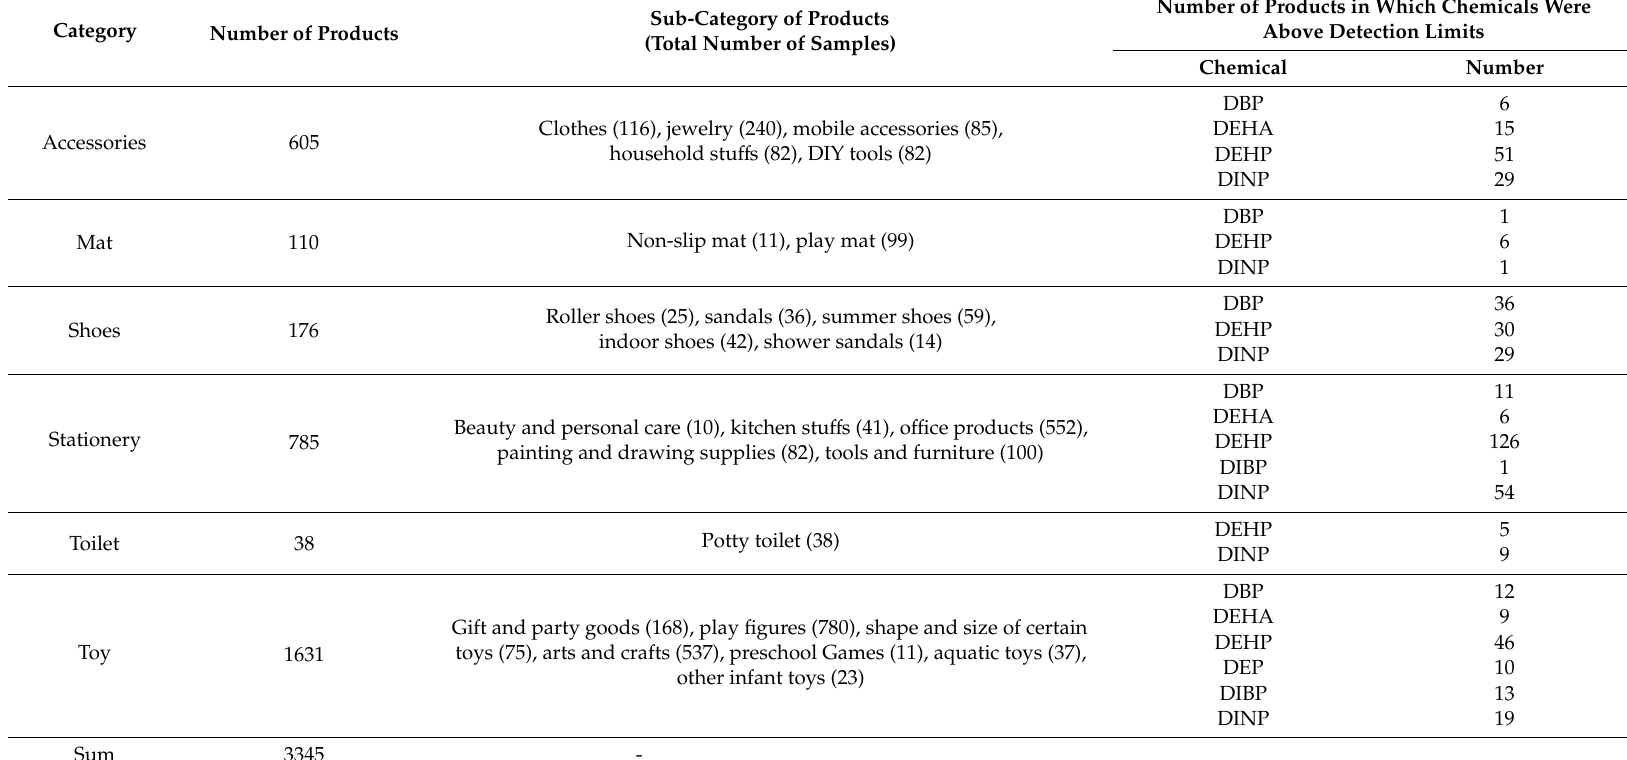
Table 1. Classification of purchased products and number of chemicals